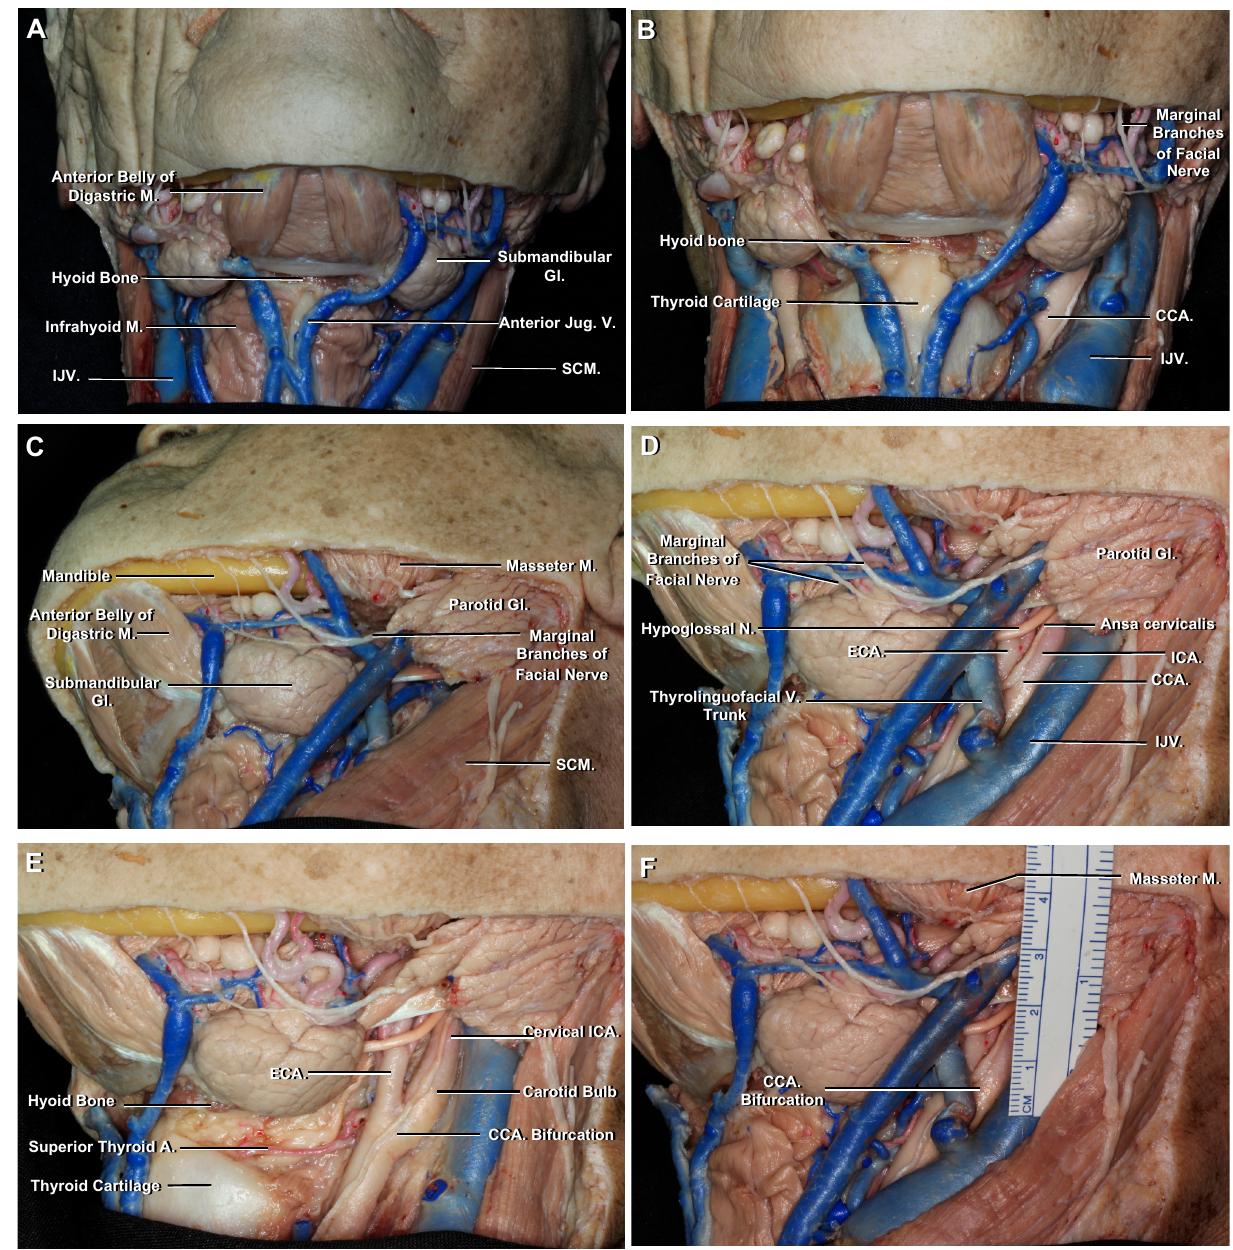
Figure 1. ( A ) Anterior view of the veins of the neck. The anterior jugular veins descend superficially to the infrahyoid muscles. The IJVs are medial to the SCM. ( B ) Enlarged view. Both CCAs run cranially in the carotid space and are medial to the IJV. ( C ) Inferolateral view, left side. The submandibular or digastric triangle is bounded anteriorly by the anterior belly of the digastric muscle, posteriorly by the posterior belly of the digastric muscle and superiorly by the mandible. ( D ) Lateral view, left side. Farabeuf’s triangle is bounded anteriorly by the thyrolinguofacial venous trunk, posteriorly by the IJV and superiorly by the hypoglossal nerve. The CCA bifurcation is seen inside this triangle. ( E ) The left CCA bifurcation is seen approximately at the level of the hyoid bone or superior border of the thyroid cartilage. At its origin, the left cervical ICA lies posterolateral to the ECA and ascends without giving off any branches. ( F ) The mandible angle is covered by the masseter muscle. The CCA bifurcation can be roughly estimated as being two finger-breadths below the mandible angle, approximately 4 cm. Abbreviations: M., muscle; Gl., gland; Jug., jugular; V., vein; IJV., internal jugular vein; SCM., sternocleidomastoid muscle; CCA., common carotid artery; N., nerve; ECA., external carotid artery; ICA., internal carotid